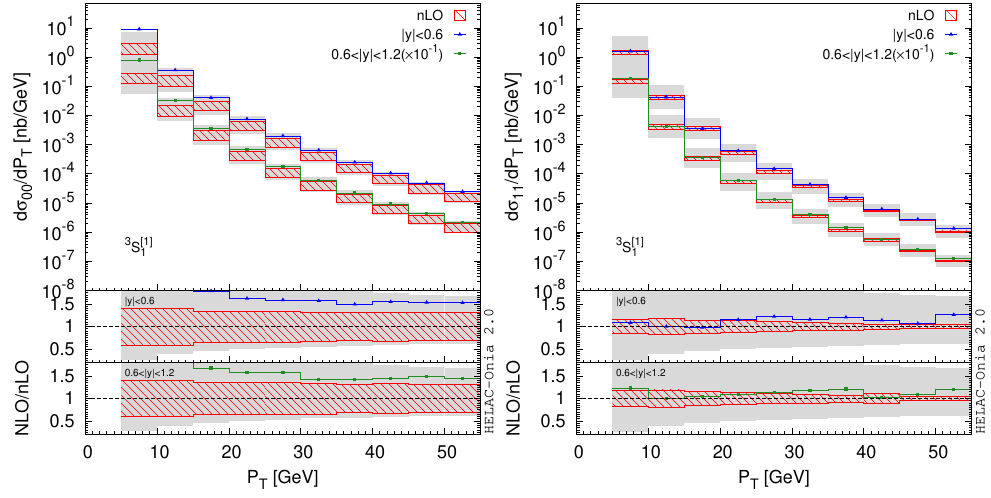
Figure 9 . Comparisons of spin-dependent differential cross sections for the Fock state 3 S [1] our nLO calculations and the complete NLO